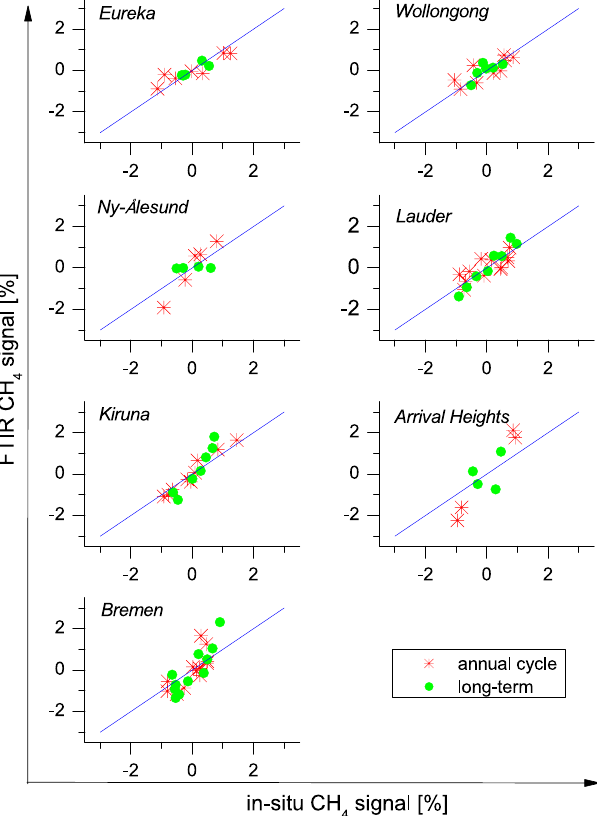
Figure 13. As Fig. 10 but for the rest of the stations and only for the seasonal/annual cycle variability and the long-term